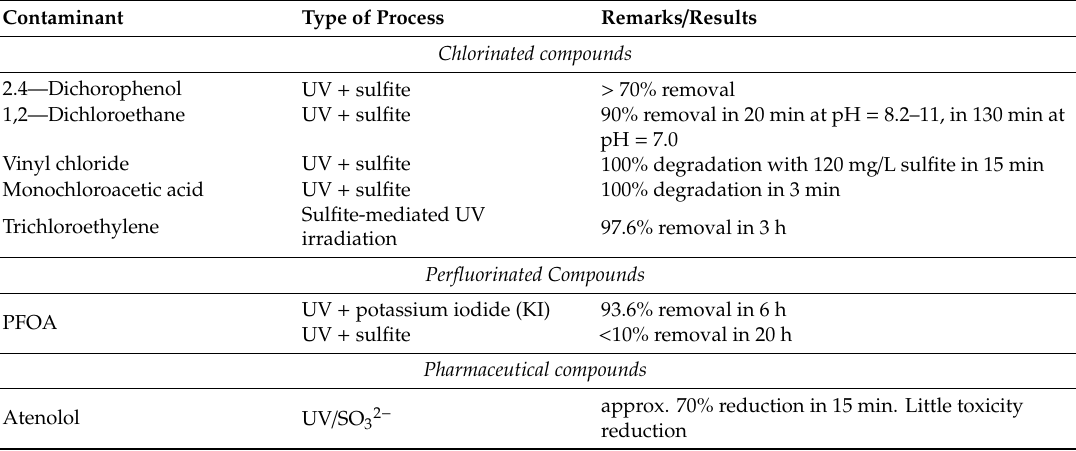
Table 7. Application of ARPs for removal of different types of compounds. Adapted from